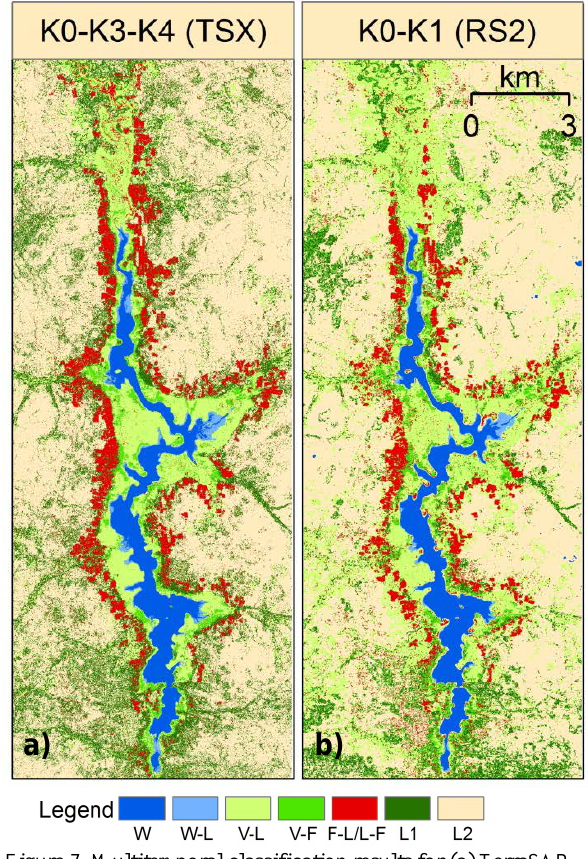
X (K 0 –K 3 –K 4 ), and (b) RADARSAT-2 (K 0 –K 1 ) Though classification using the same classes (water, flooded vegetation, irrigated fields and non-wetland) on a single dual- pol image was only successful for TerraSAR-X but not RADARSAT-2, the multitemporal classification proofs that using the full time series stack a classification is possible, and the same information can be extracted from X-band dual-co- polarimetric as well as C-band dual-cross-polarimetric channels, as well as a combination of the two